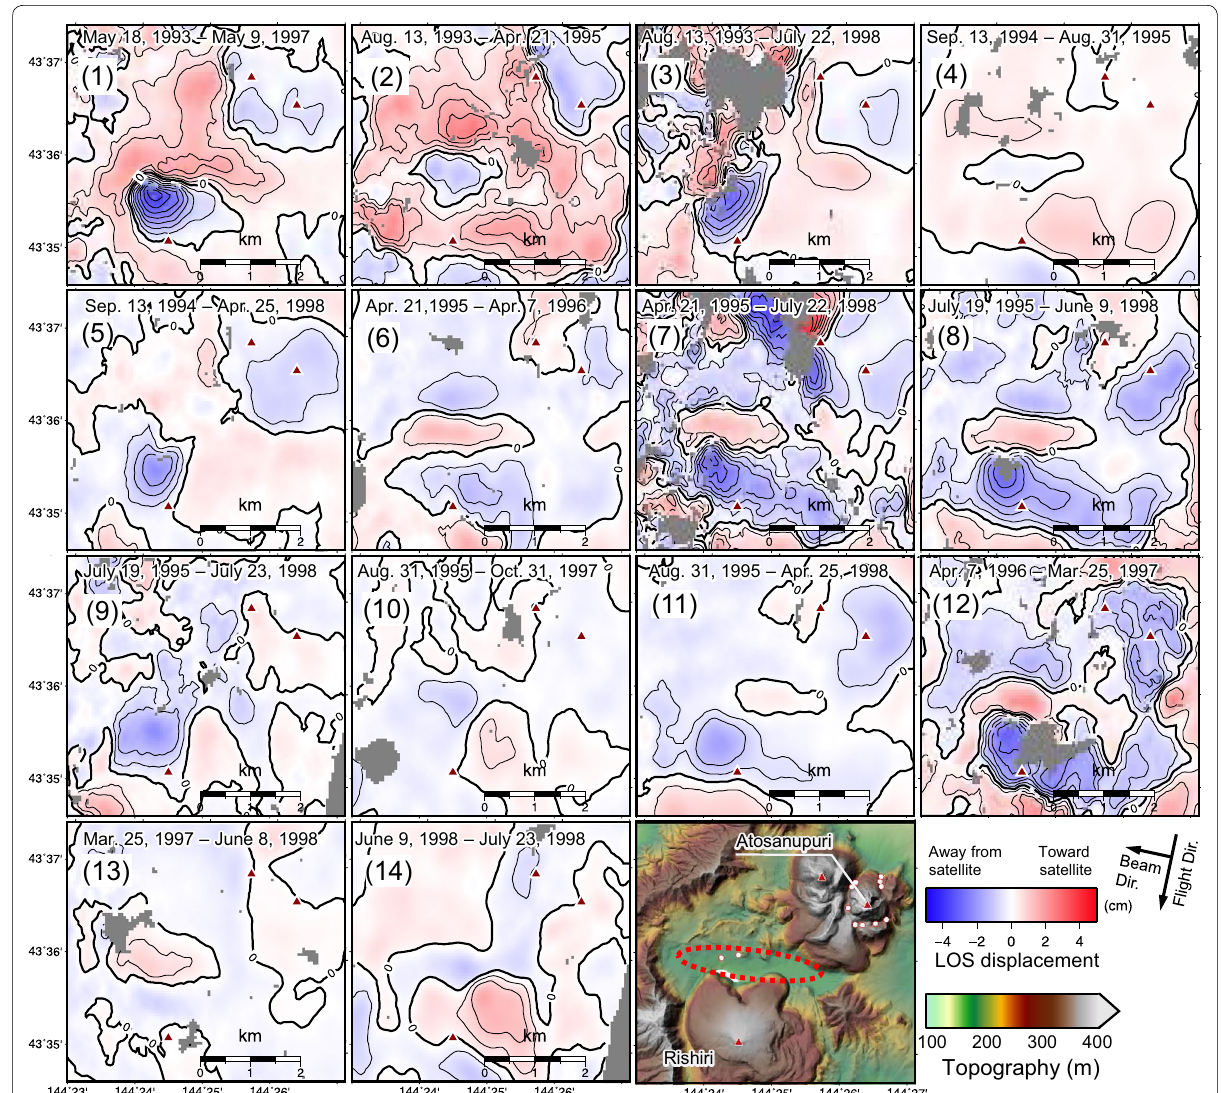
Fig. 6 High-pass-filtered (7-km cutoff) close-up view of unwrapped interferograms around the center of the deformation dome. Each number indi- cates the InSAR pair in Table 1. Red triangles indicate major lava domes belonging to the Atosanupuri volcanic complex. Contour interval is 0.5 cm. Lower right : Topography of the Atosanupuri volcanic complex. Red dotted lines show the area of a small valley (or basin) between lava domes in the topography. Small white circles show fumaroles. The target area is shown in Fig.